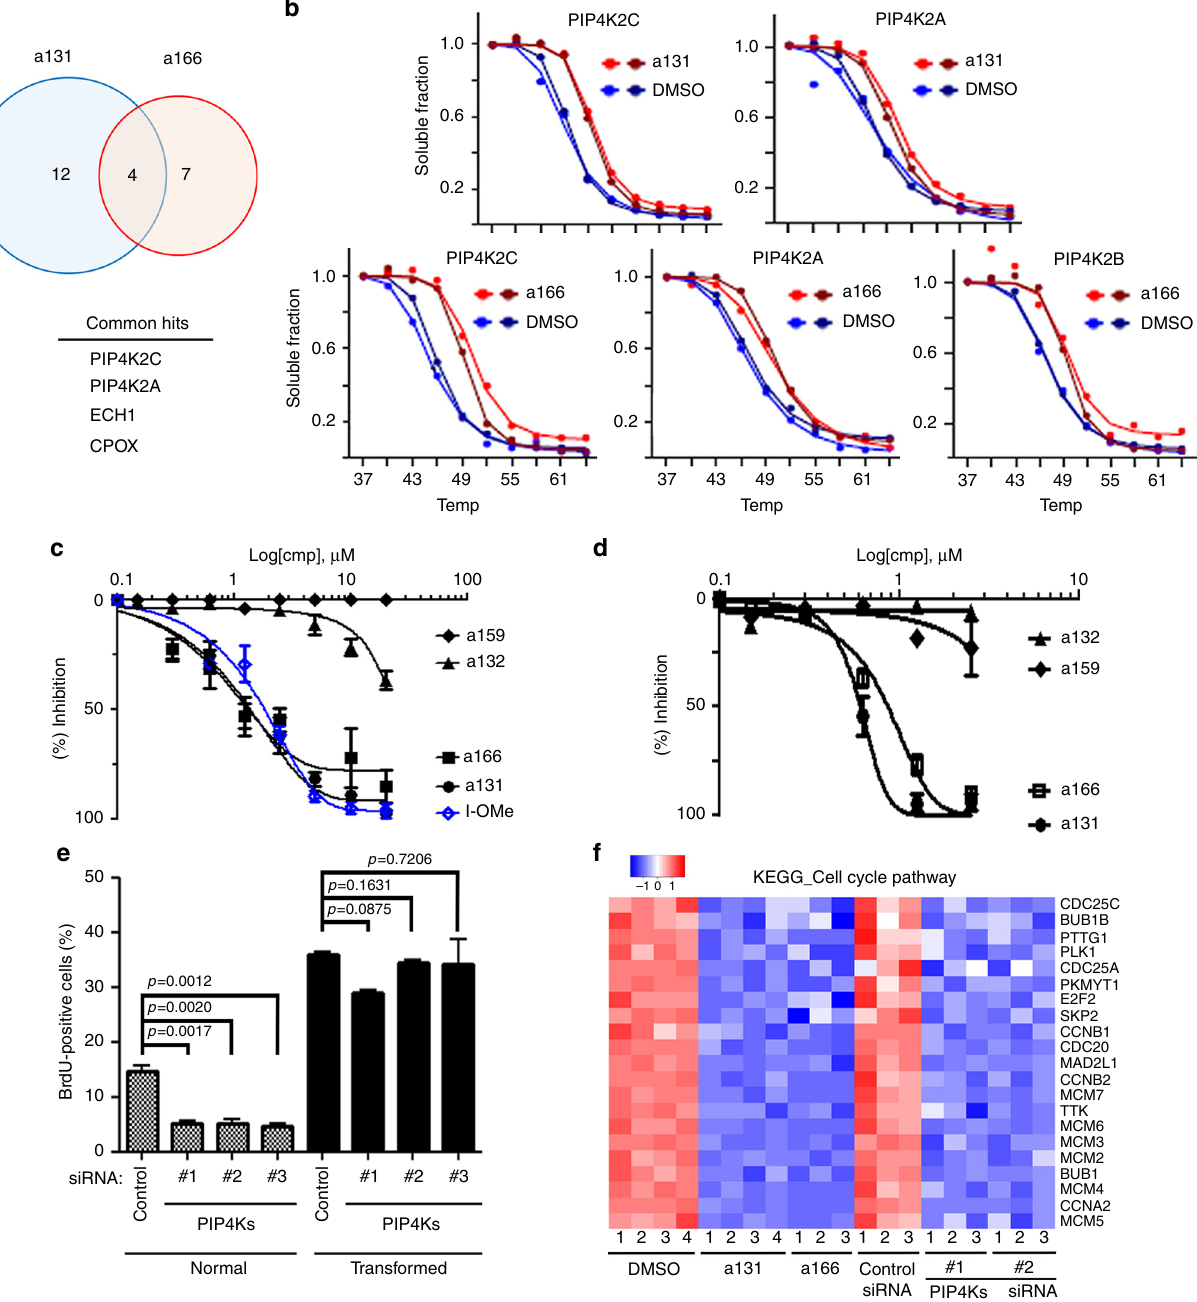
Fig. 2 Identi fi cation of PIP4Ks as targets of a131 responsible for selective growth arrest in normal cells. a , b Target identi fi cation using CETSA. All experiments were performed in two fully independent replicates. a Venn diagrams of positive hits from a131 and a166 with the list of commonly targeted hits. Individual hits were ranked by distances (Methods). b Melting curves for PIP4K isoforms in duplicated experiments of a131 vs. DMSO (top) or a166 vs. DMSO (bottom) treatment. c , d PIP4Ks enzyme activity assays using PI5P as substrate (Methods). Inhibition curves ± S.D. ( n = 4) of the indicated compounds are shown. c In vitro PIP4K2A enzyme activity pre-incubated with the indicated compounds. d In vitro PIP4Ks activity using HeLa cells in order to verify cell type-independent inhibition by a131 or its indicated derivatives. The compounds were further added to cell lysates at the indicated concentrations during the measurement of PIP4K activity. e BrdU incorporation assay as in Fig. 1c. Normal and transformed BJ cells were transfected with control or three different sets of PIP4Ks siRNAs (mixture of PIP4K2A, PIP4K2B, PIP4K2C) for 48 h. The percentage of cells with BrdU-positive populations is shown with mean values ± S.D. ( n = 3). Two-tailed unpaired t tests were performed to determine statistical signi fi cance. Note that the differences in the percentage of BrdU-positive cells between normal and transformed BJ cells were due to a relatively slower growth of normal BJ cells as compared to transformed cells, and not due to a signi fi cant growth arrest with the control siRNA. f GSEA enrichment plot and heatmap of KEGG cell cycle pathway genes. Normal BJ cells were treated with a131 and a166 at 5 μ M for 24 h or transfected with indicated siRNAs for 48 h. The per-sample expression pro fi les of these genes are depicted in the heatmap using an intensity-based, row-normalized color scale from blue to red, with blue indicating lower expression